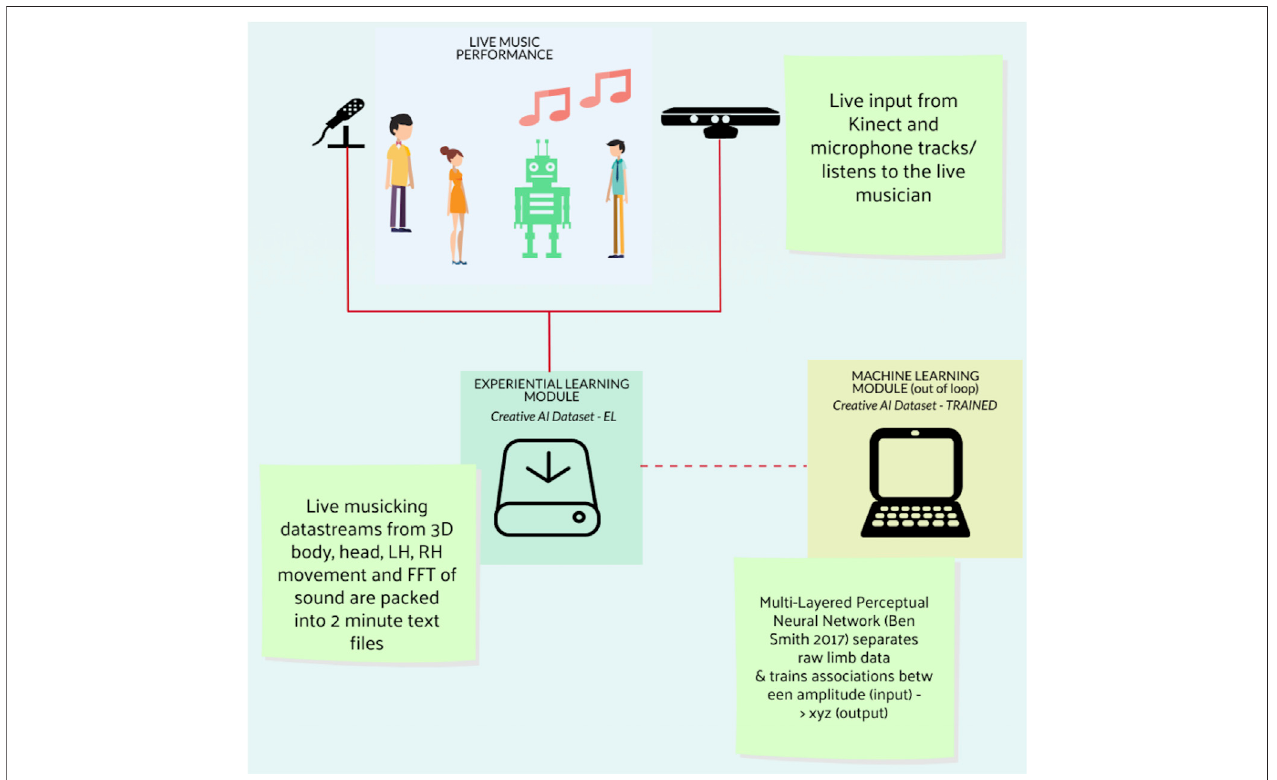
FIGURE1| Experientiallearningprocess.Thisimageoverviewsthebasictechnical/datastructureatplayinEMRv1andalsoisthefoundationforfurtheriterationsofEMR.